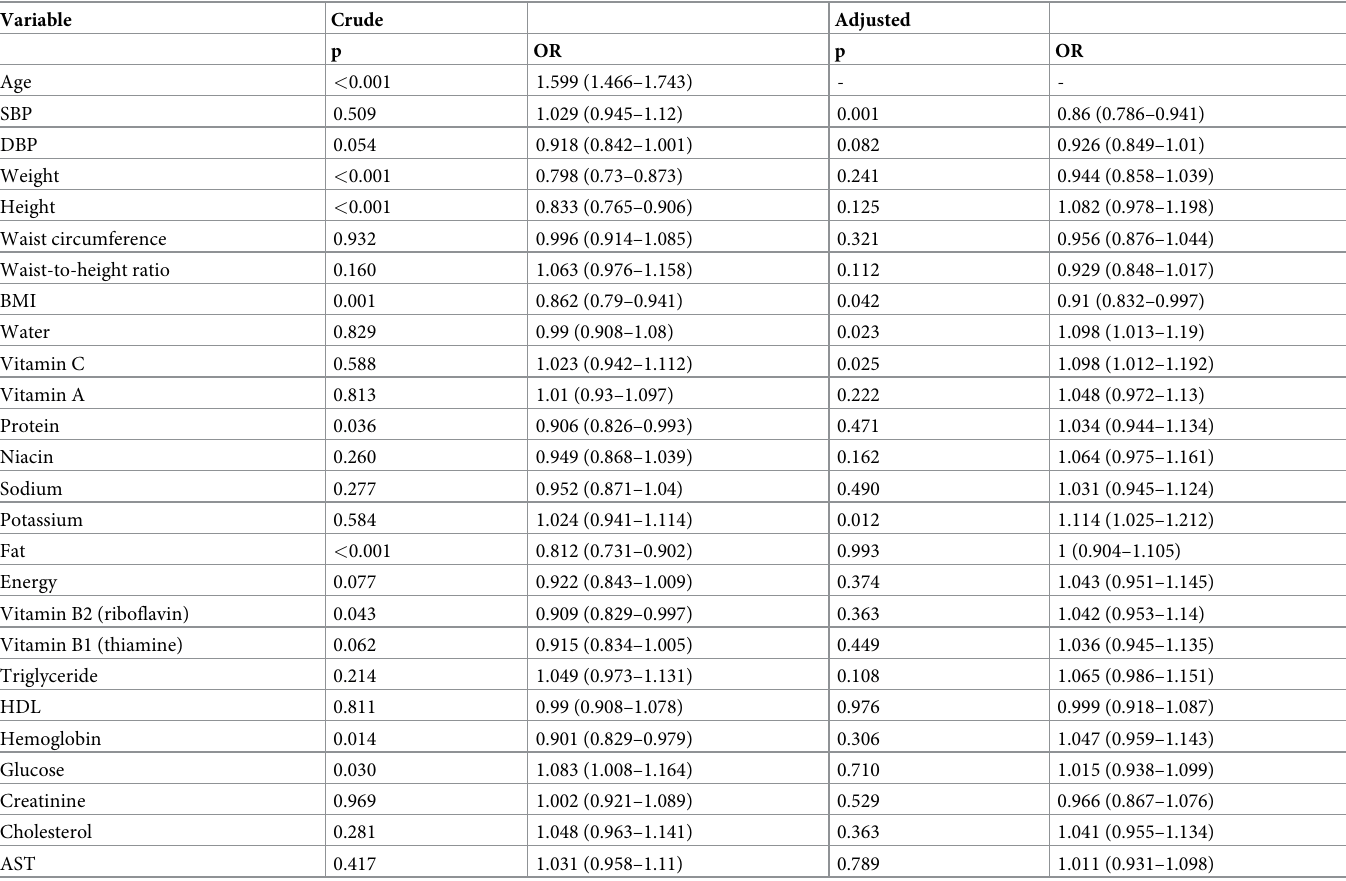
Table 2. Association of PUD with obesity indices, nutrients, and blood parameters in Korean